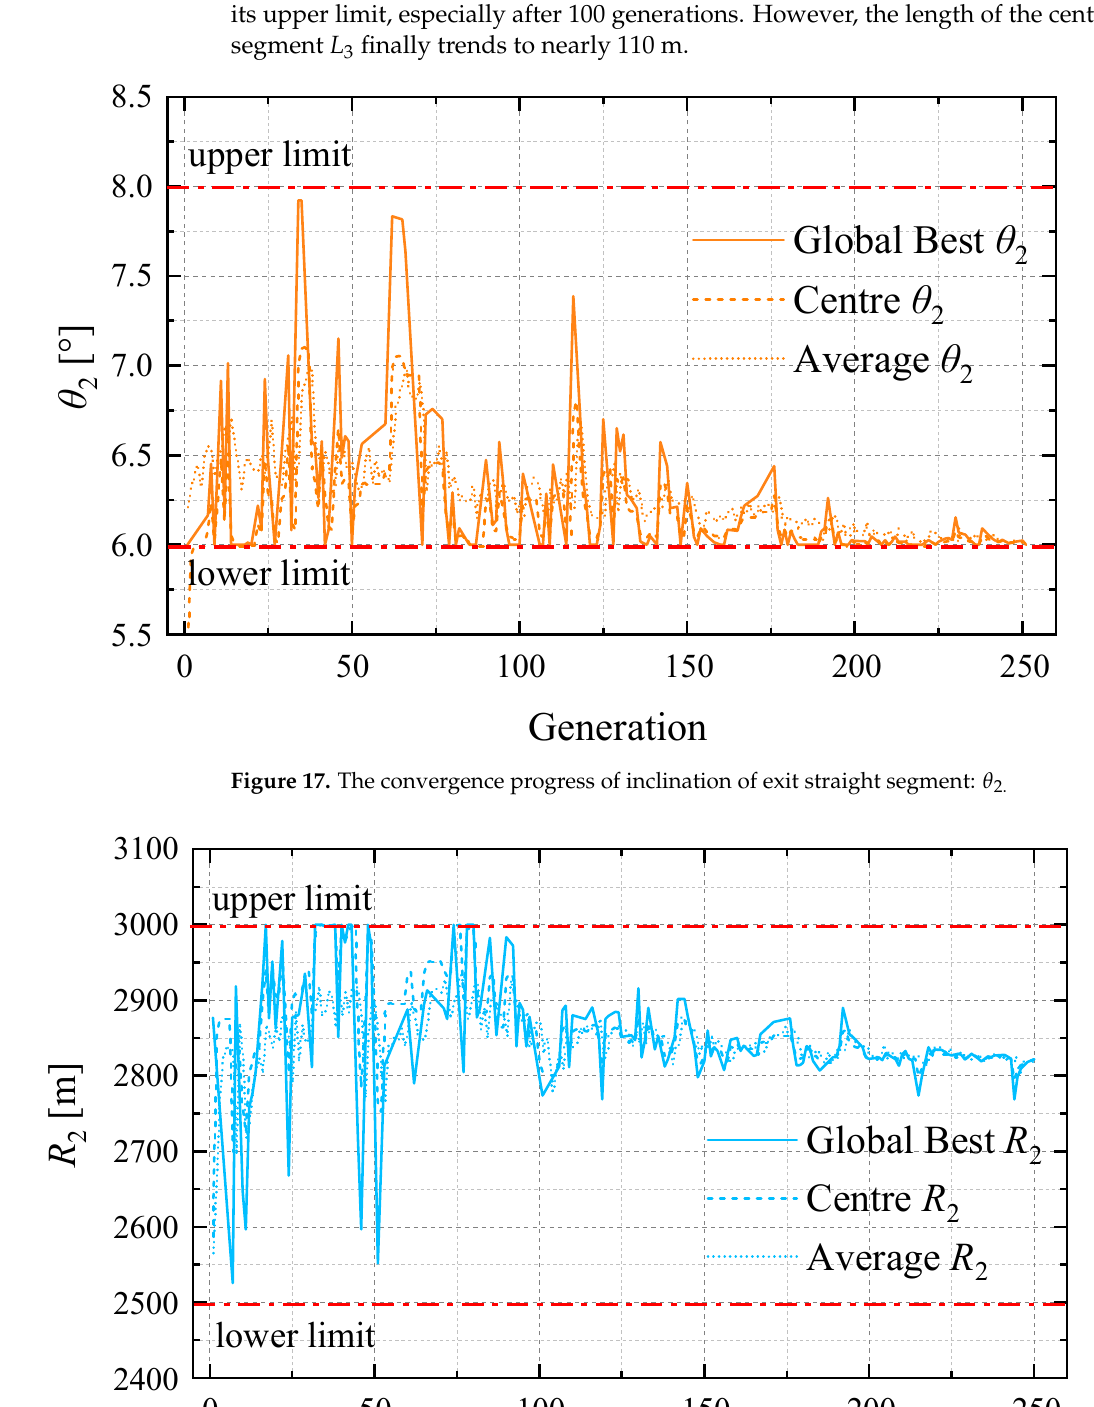
Figure 16. The convergence progress of inclination of entry straight segment: θ 1.